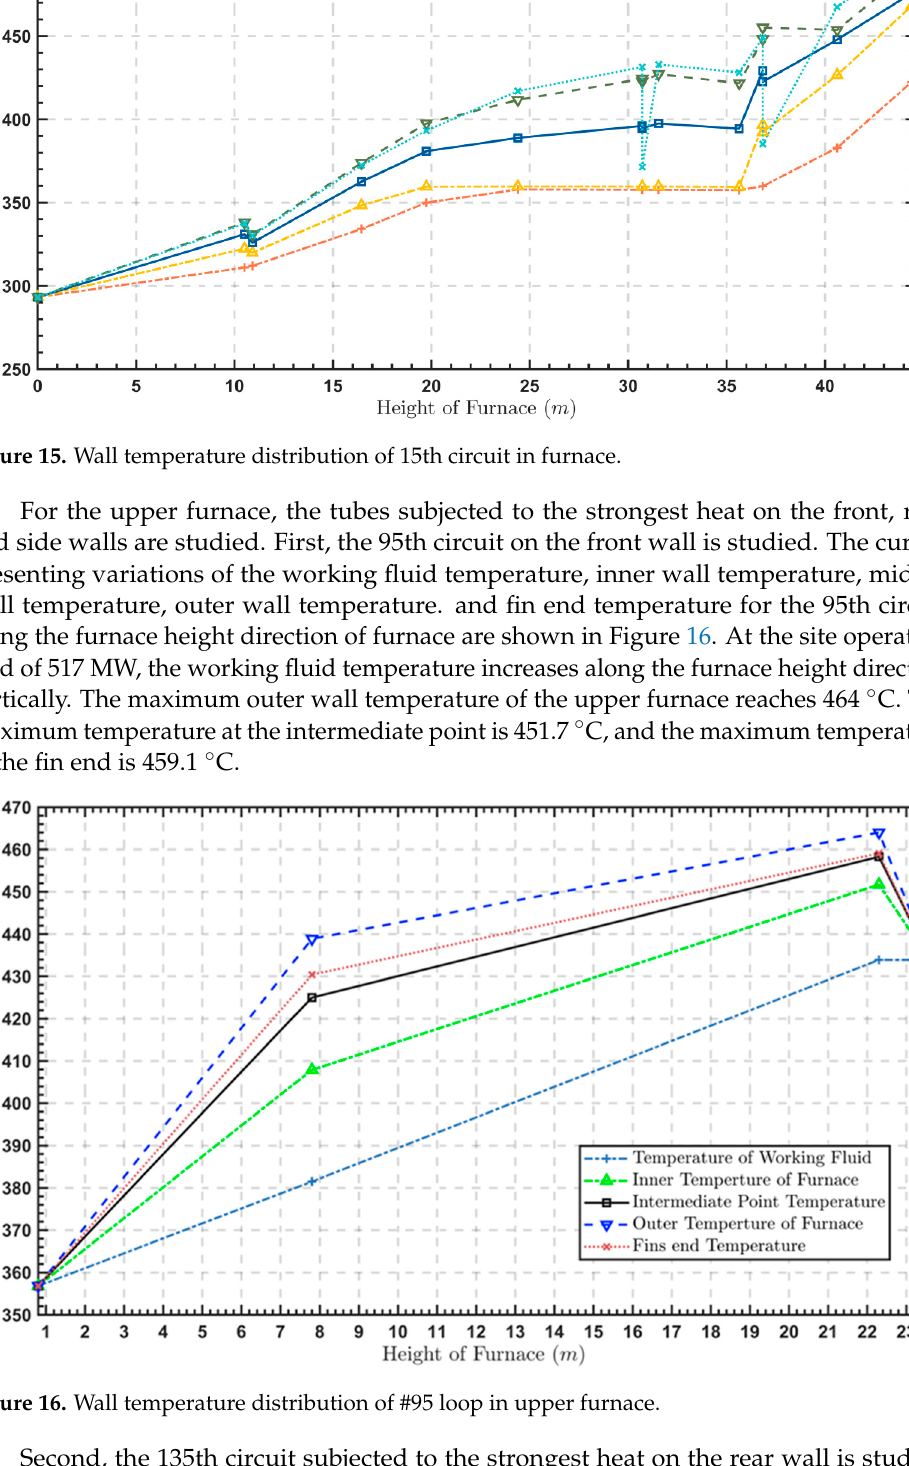
Figure 16. Wall temperature distribution of #95 loop in upper furnace.